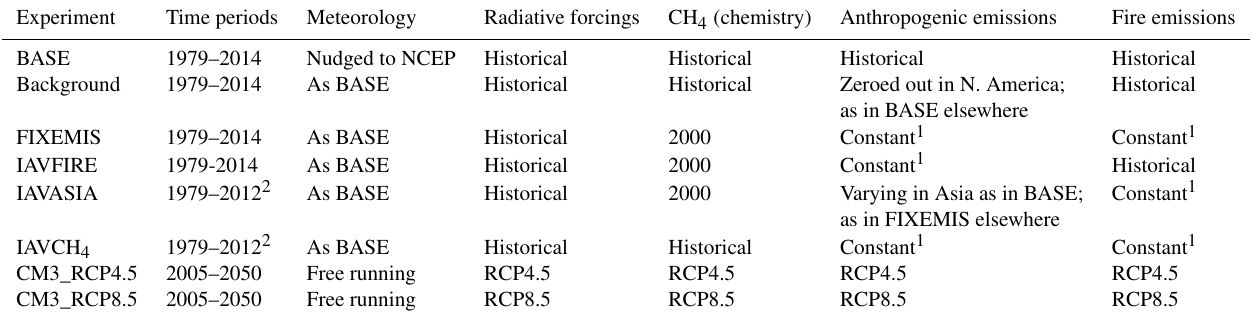
Table 1. Summary of forcings and emissions used in AM3 hindcasts and CM3 projections.